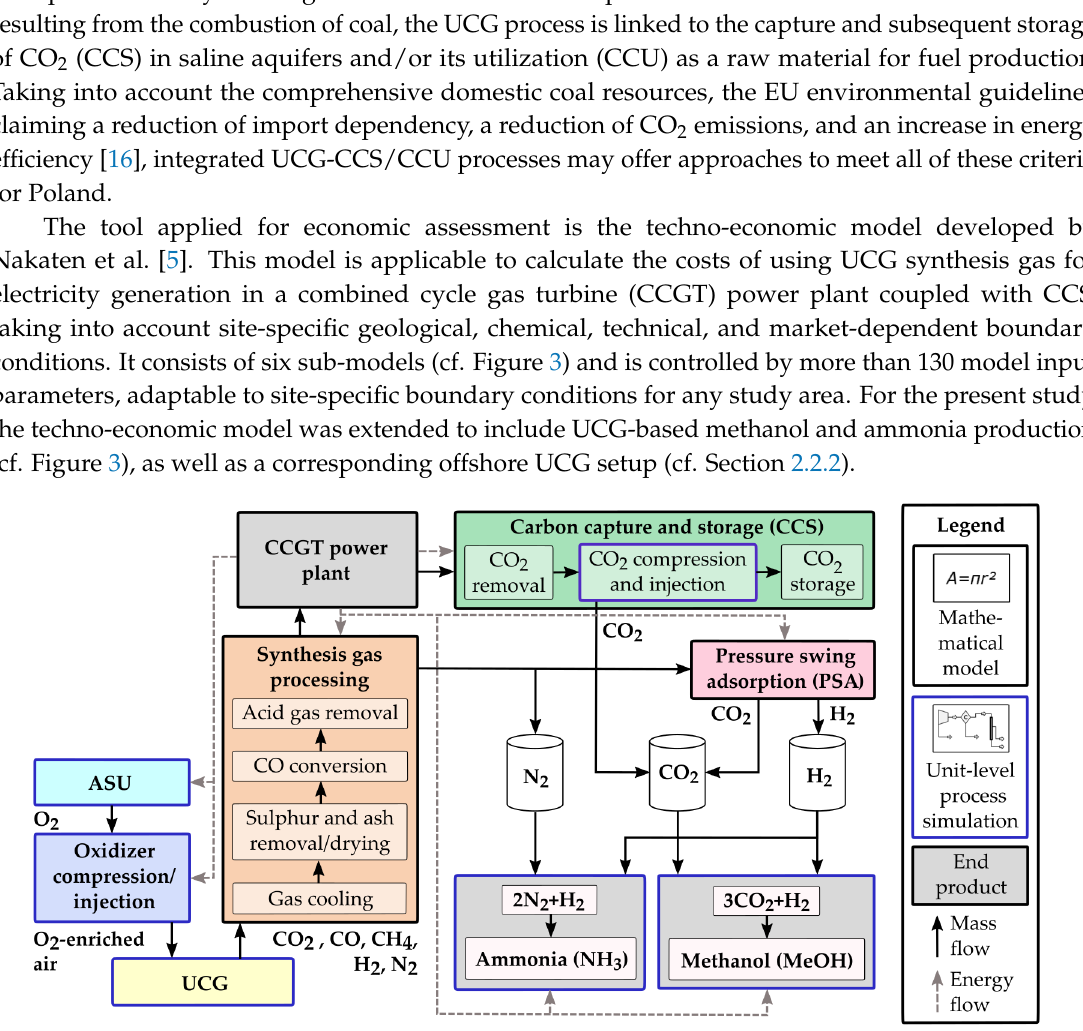
Figure 3. Techno-economic model for cost determination of integrated underground coal gasification (UCG), carbon capture and storage (CCS)/carbon capture, and utilization (CCU) scenarios based on Nakaten et al. [5] and extended to fulfill the requirements of the present